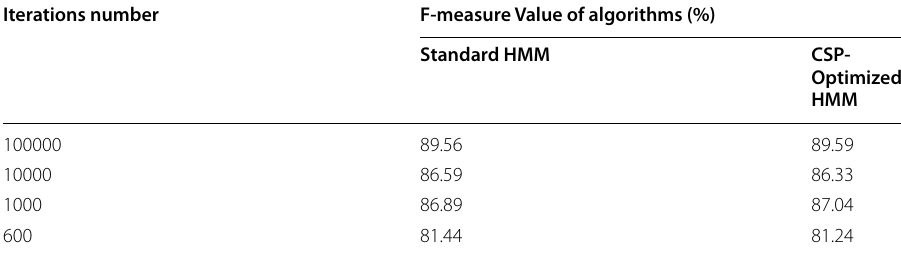
Table 9 F-measure values comparison Iterations number